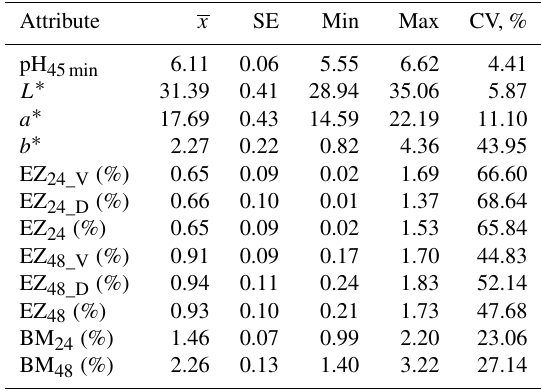
Table 1. Means ( x ) with standard error (SE), minimum (Min), max- imum (Max), and coefficient of variation (CV) for meat quality at- tributes of mutton ( n =